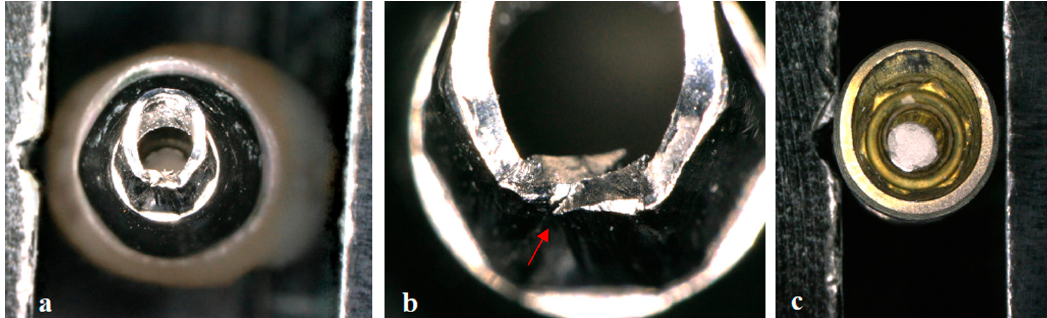
Figure 5. Mode of failure in aftermarket titanium abutment: ( a ) deformation of hexagon portion of the abutment; ( b ) fracture line over the abutment (arrow); ( c ) deformation of the implant with retentive screw fracture, the fracture surface of retentive screw was at the level of the implant platform.